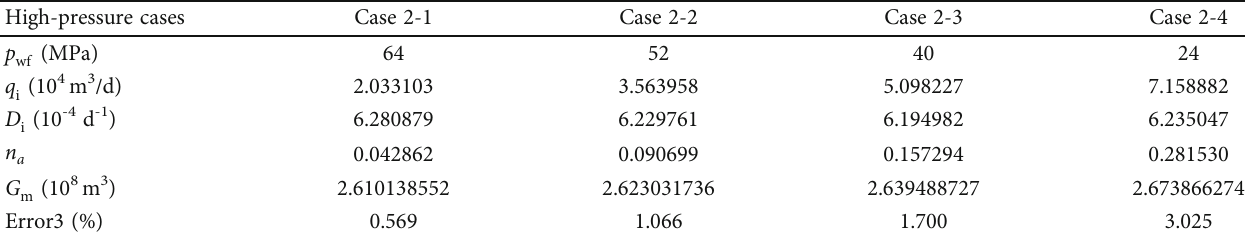
(b) The analysis results of modi fi ed Stumpf method for numerical cases with high